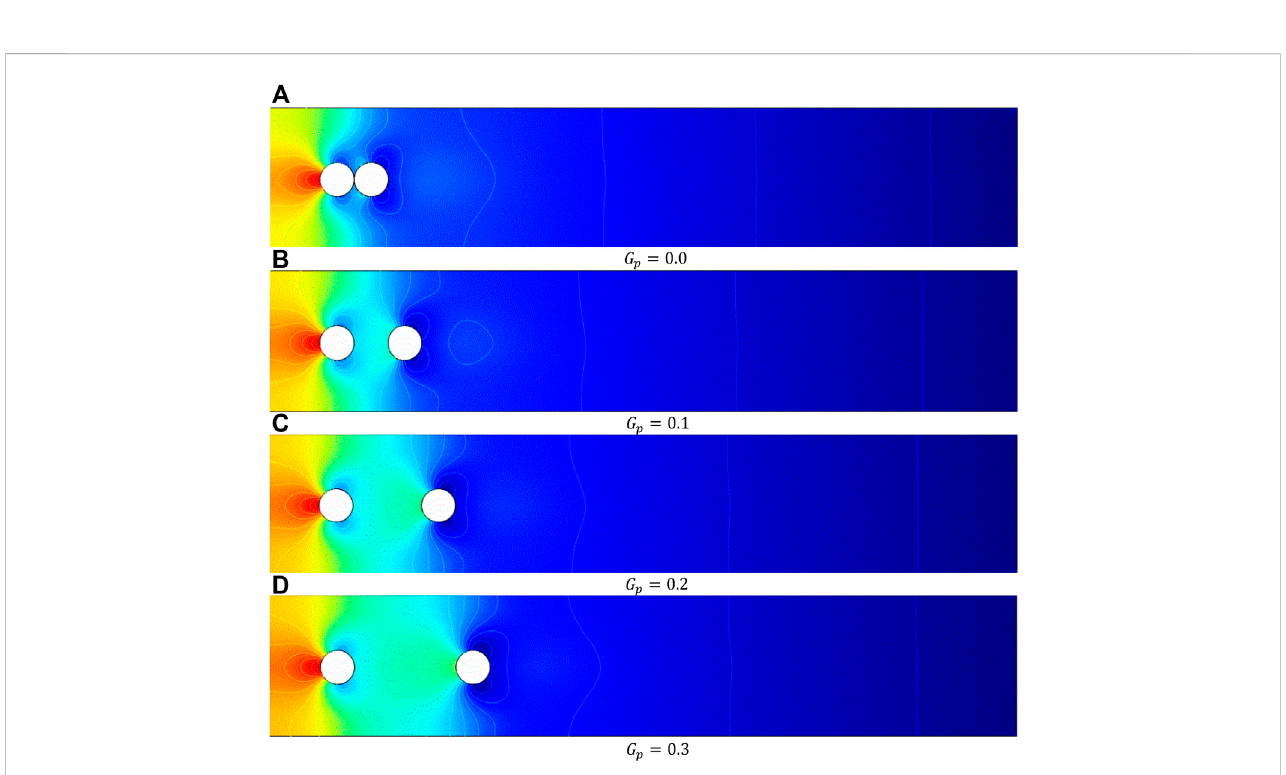
FIGURE 9 In fl uence on pressure for various gap spacings of cylinders with n (cid:2) 1 . 5 and Re (cid:2) 20.